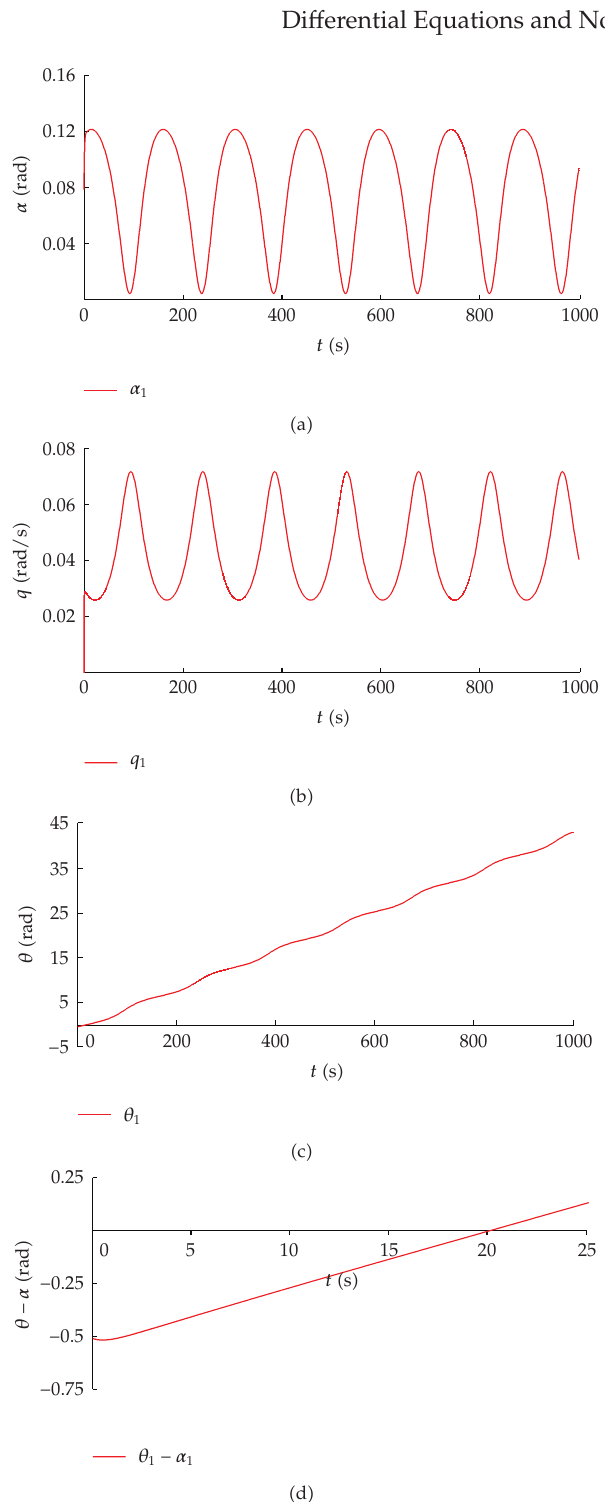
(cid:7) 0 . 0786697 (cid:5) rad (cid:6) (cid:7) 4 . 509 ◦ ; q (cid:6) 1